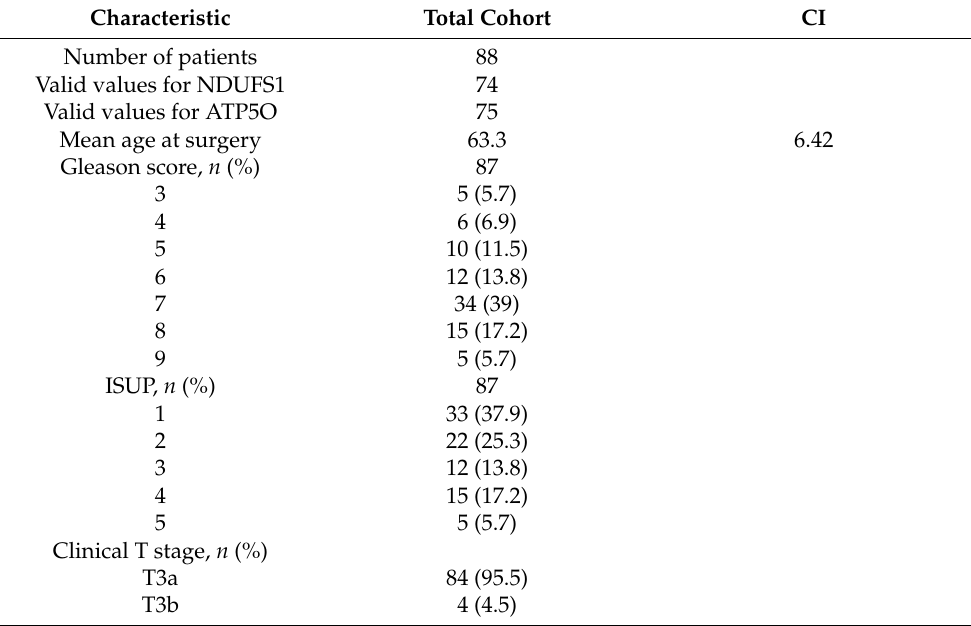
Table 1. Clinical characteristics of the PCa patient cohort stained for NDUFS1 and ATPO.